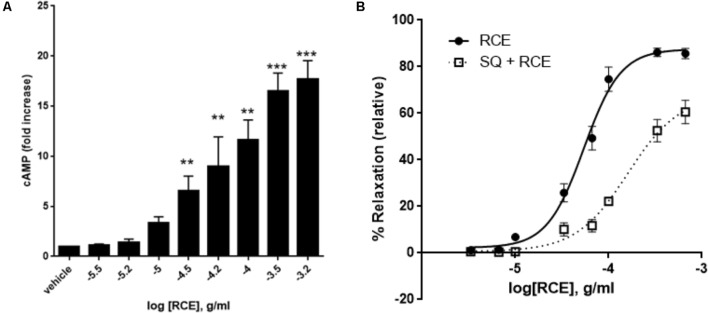
Role of cAMP and adenylyl cyclase in RCE-elicited aortic relaxation. (A) Accumulation of cAMP in aortic rings in the absence or presence of increasing doses of RCE. Each bar represents mean ± SEM (∗∗p < 0.001 and ∗∗∗p < 0.0001). (B) Endothelium-intact rings were treated with cumulative doses of sumac in the absence (RCE; circles) or presence (SQ + RCE; squares) of SQ22536 (100 μM). Values are mean ± SEM, n = 7; p < 0.05.